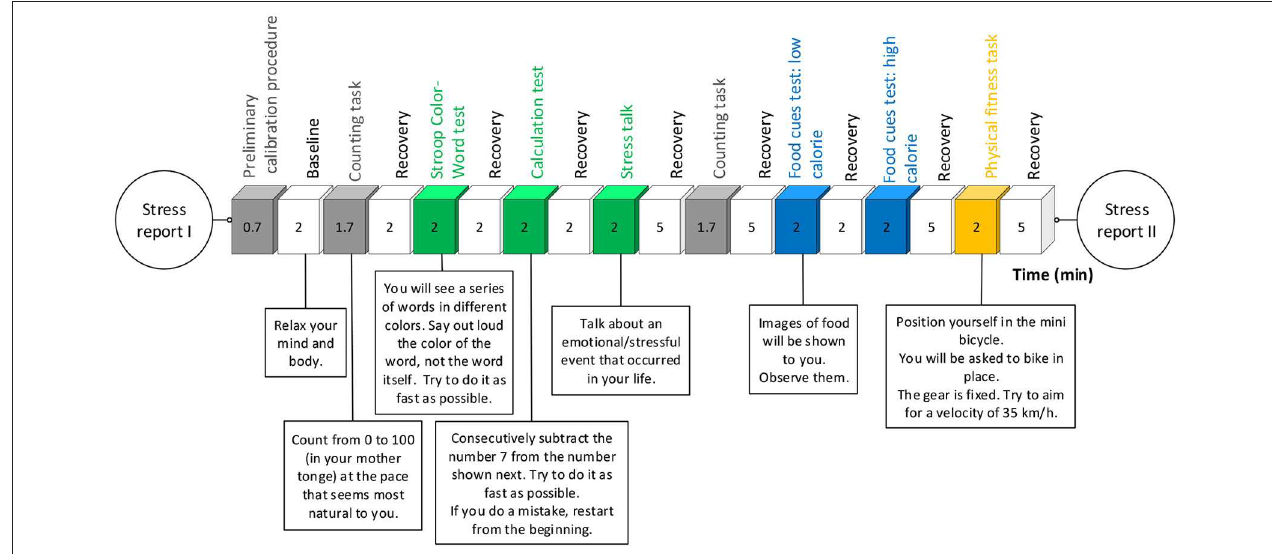
FIGURE 4 | Stress task: timings, task modules, and task explanation.